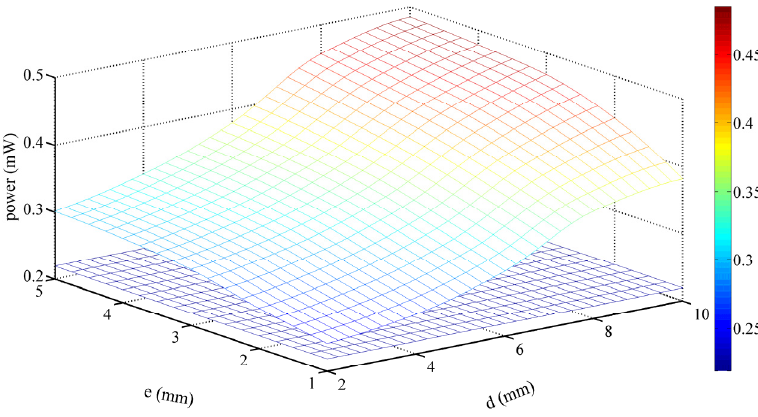
Figure 8. Maximum output power versus eccentricity distance e and cylinder eccentric hole diameter d .